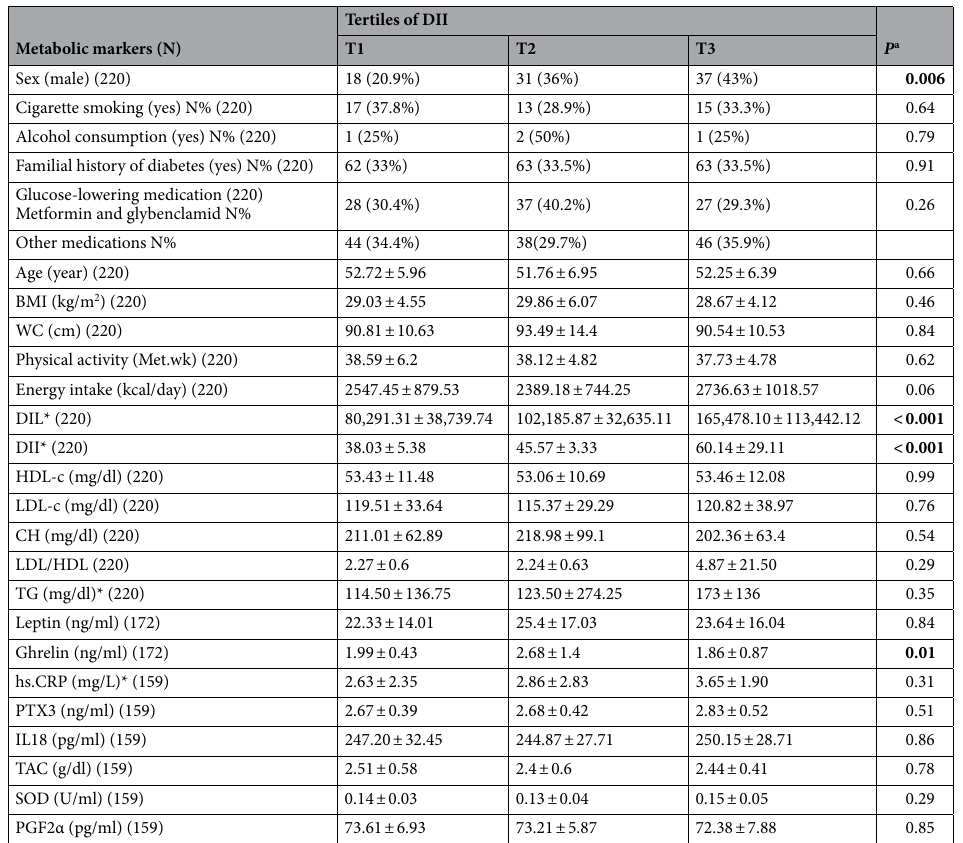
Table 3. The association between baseline characteristic and metabolic markers with dietary insulin index (DII). Data are presented as mean ± standard deviation (SD) or percent or Median ± IQR* (TG, hs.CRP, DIL and DII). DIL: dietary insulin load; DII: dietary insulin index; BMI: body mass index; HDL-c high density lipoprotein cholesterol; LDL-c: low density lipoprotein cholesterol; CH: cholesterol; TG: triglyceride; CRP: C-reactive protein; PTX3: Pentraxin 3; IL18: interleukin 18; TAC: total antioxidant capacity; SOD: superoxide dismutase; PGF2α: prostaglandinF2α . a : Obtained from ANOVA. Bold values denote statistical significance at the p < 0.05